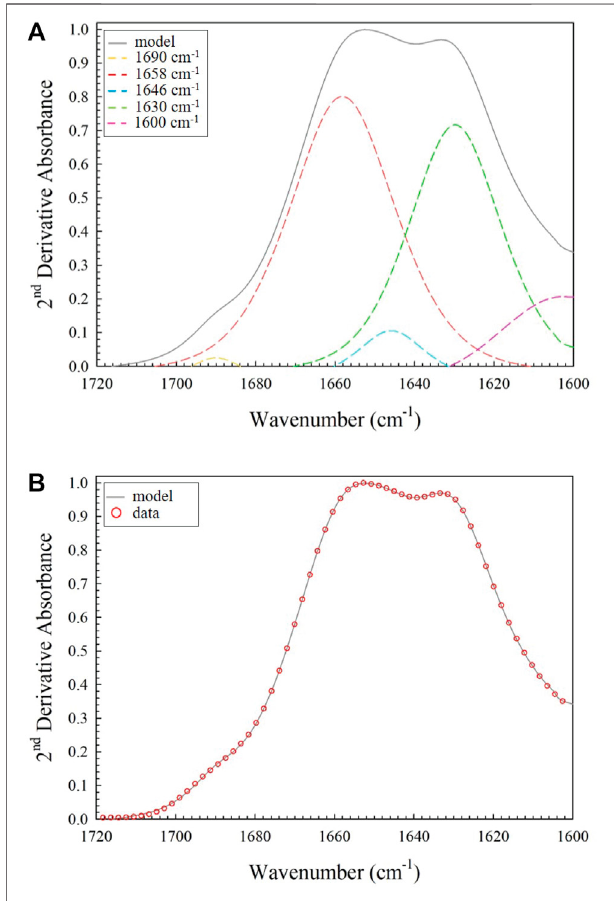
FIGURE9|(A) Fitofthefournon-zeroareapeaksidenti fi edintheamide I region only (1690, 1658, 1646 and 1630 cm − 1 – also included is the 1600 cm − 1 transition peak used to model the shape between the amide I and II regions); (B) Fit of the model (grey line) to the data (red open circles) for the amide I only. The most striking difference is the signi fi cantly smaller component peak in the 1690 cm − 1 region.